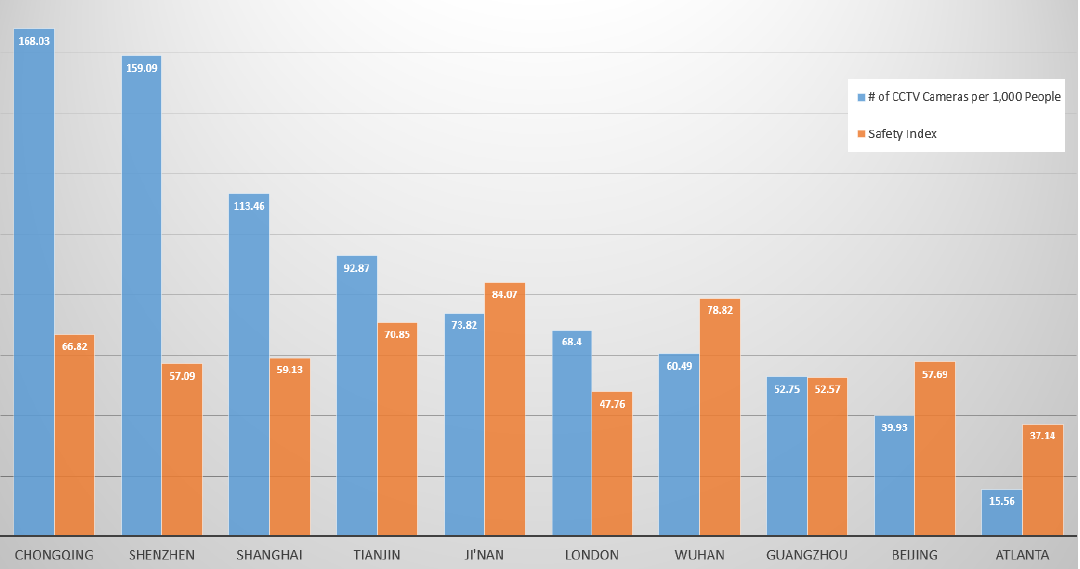
Figure 15. Top 10 cities according to the number of surveillance